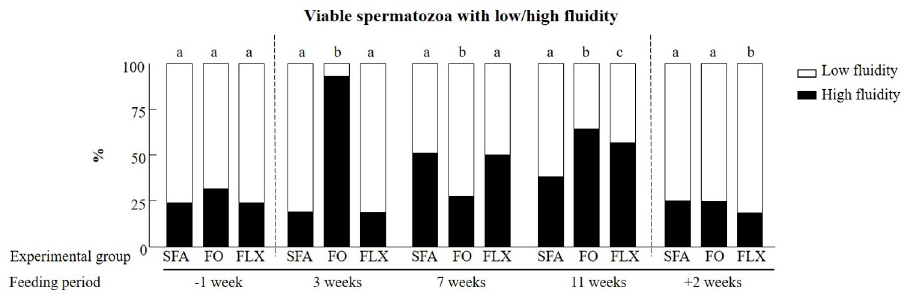
Fig 7. The effect of omega-3 sources flaxseed and fish oil on membrane fluidity in viable spermatozoa. The distribution of viable spermatozoa expressing high or low membrane fluidity within each experimental group: saturated fatty acid (SFA; control), fish oil (FO), and flaxseed oil (FLX) as determined by flow cytometer detection of the fluorescent probe merocyanine 540 during the experimental period: before (-1 week), during (3, 7, and 11 weeks), and after (+2 weeks) the feeding trial is presented. Different letters above the columns indicate significant differences relative to the SFA group at each time point ( P <